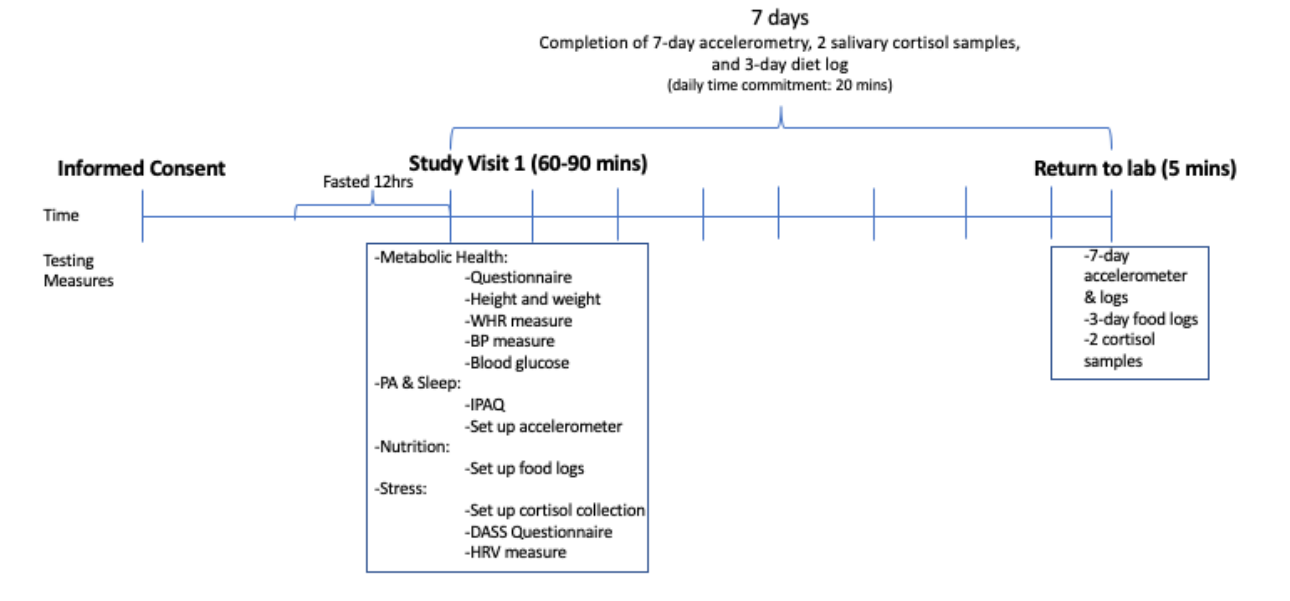
Figure 1. Illustration of the study timeline; BP: blood pressure, DASS: Depression Anxiety Stress Scale, HRV: heart rate variability, IPAQ: International Physical Activity Questionnaire, PA: physical activity, WHR: waist-to-hip